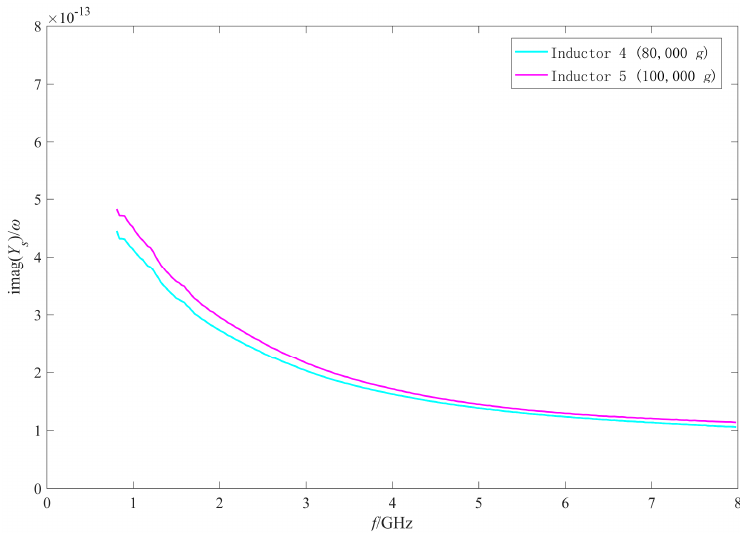
Figure 24. The imaginary part of 𝑌 (cid:3046) of the failed inductors after shock test.